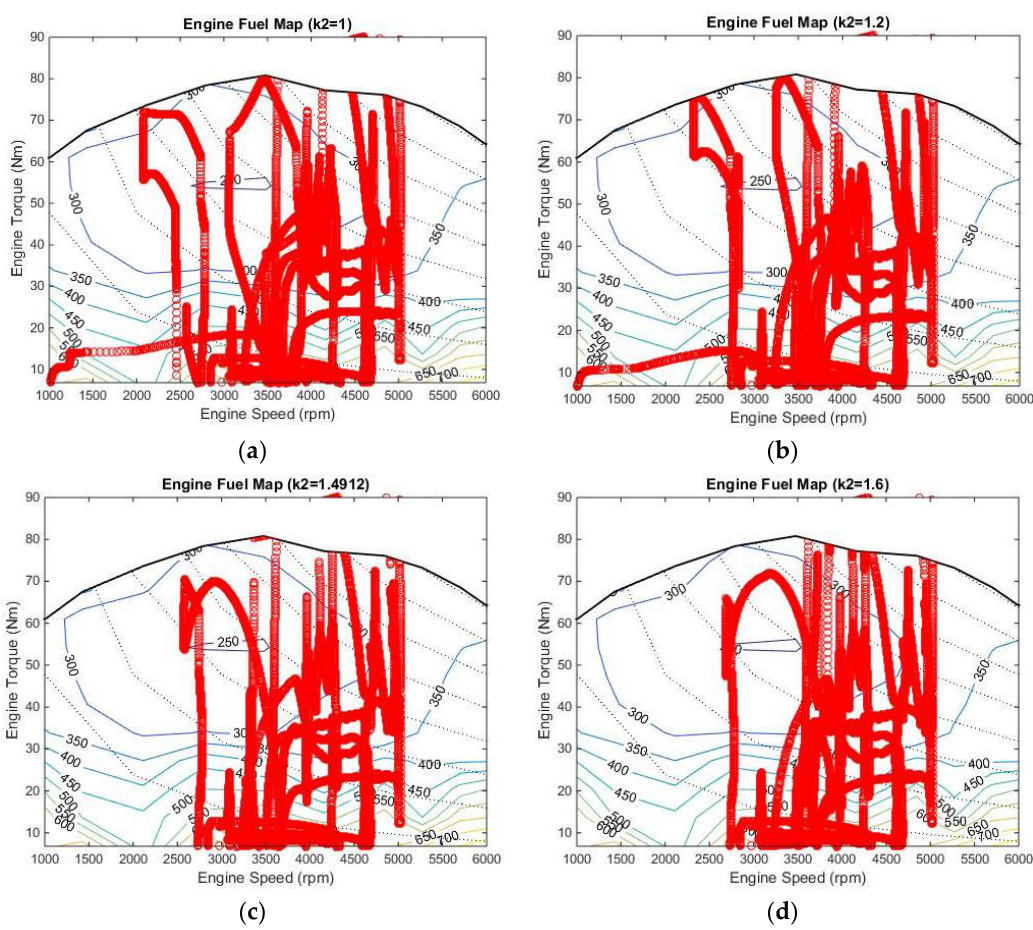
Figure 15. ( a ) Engine operation points (with 𝑘 2 = 1 ). ( b ) Engine operation points (with 𝑘 2 = 1.2 ). ( c )